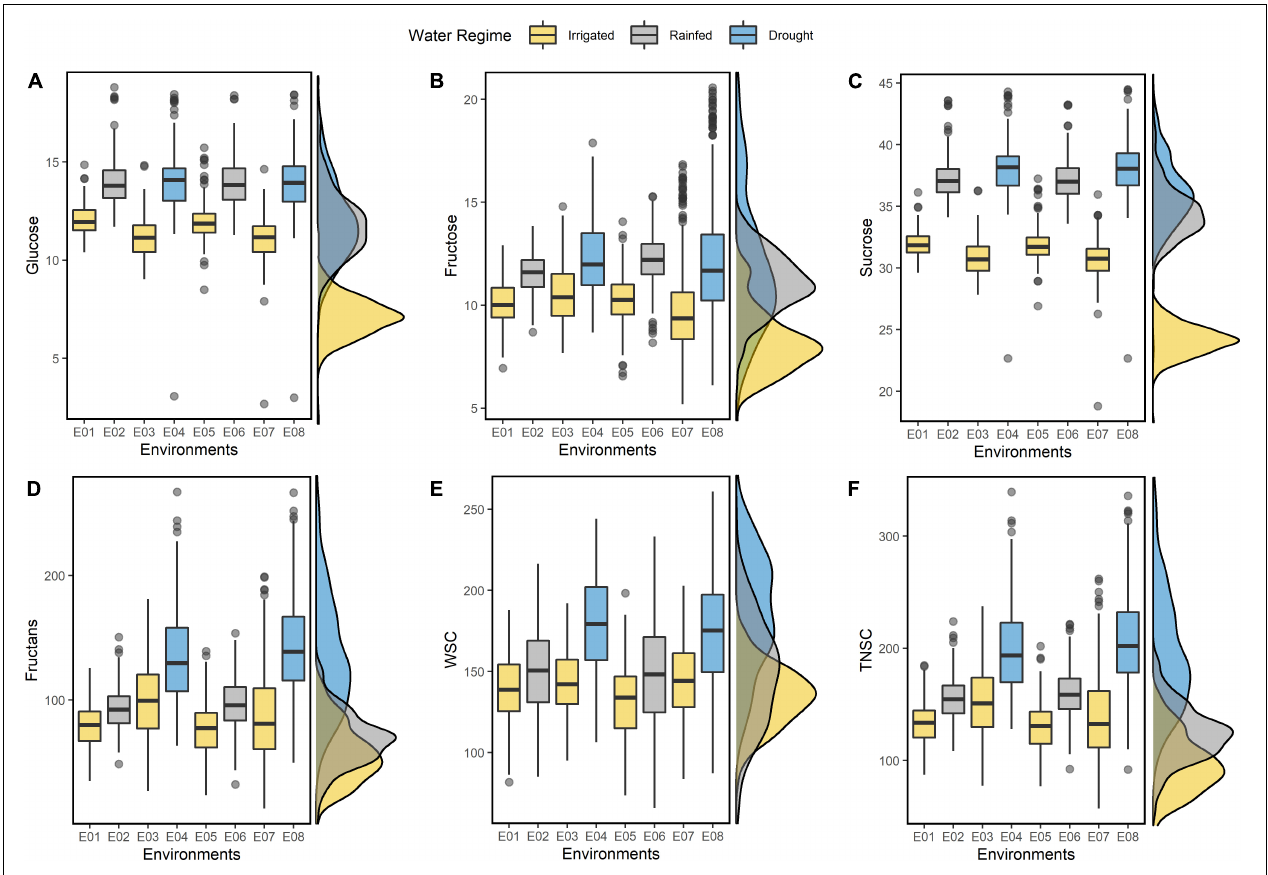
FIGURE 1 | Boxplots summarizing the resulting BLUEs of glucose (A) , fructose (B) , sucrose (C) , fructans (D) , WSC (E) , and TNSC (F) estimated under eight different environments (E01-E08). On the left of each boxplot, the corresponding density plots show the distribution pattern of the traits with resulting BLUEs estimated by pooling of environments across corresponding water